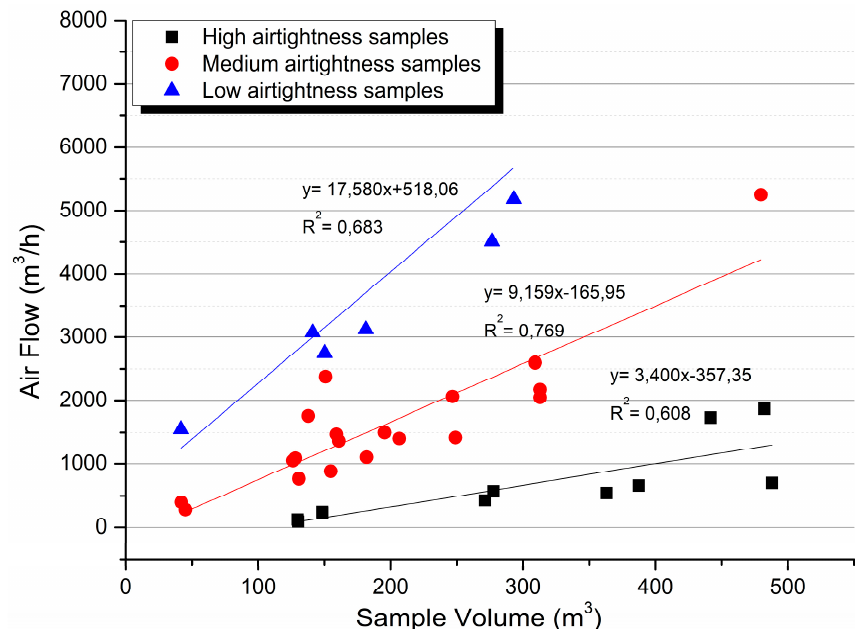
Figure 8. Correlation between airflow and volume of the tested enclosures, according to the identified airtightness levels.